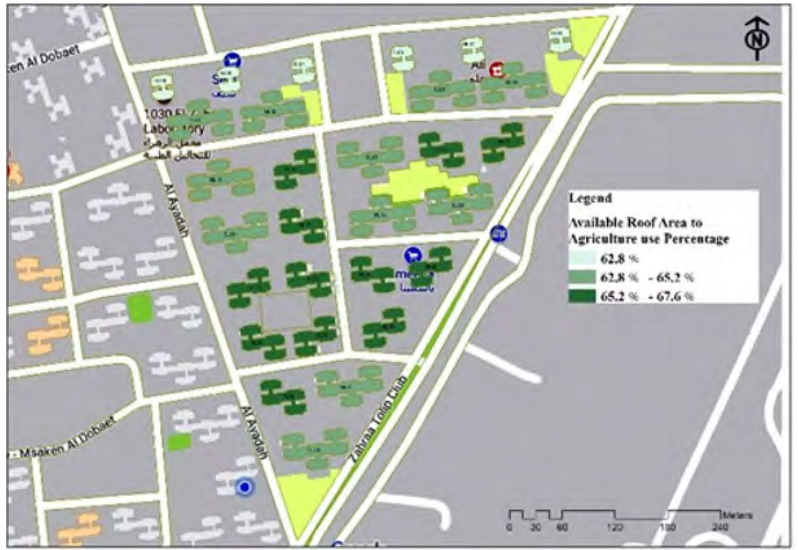
Figure 17. Available roof area to Agriculture use %